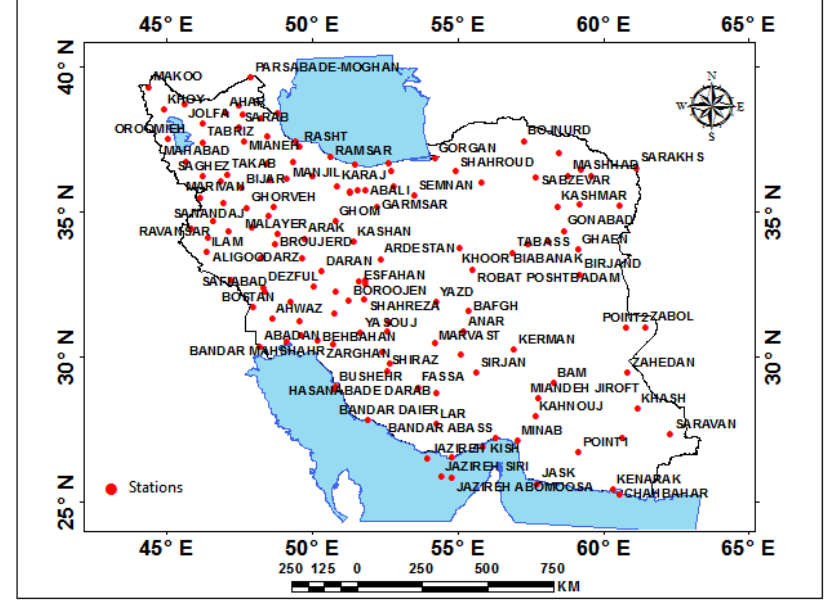
Figure 2. Selected stations.